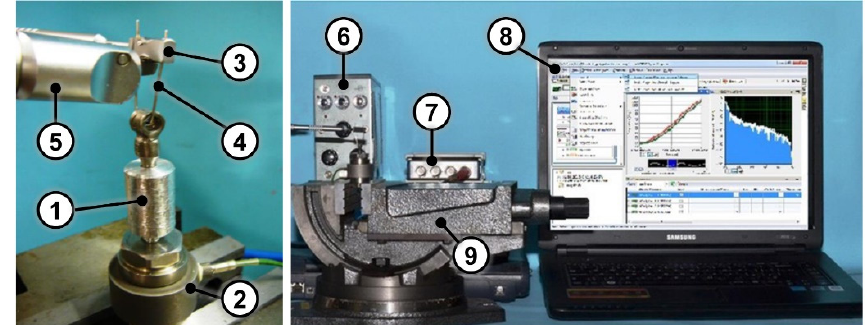
Figure 1. ( Left ) Close up view of the test setup with the cylindrical aluminum support (1), the load cell (2), the loop holder (3), the loop (4) and the Coronaflex® (5); ( Right ) Test setup composed of the amplifier (6), the data acquisition board (7), the laptop equipped with LabVIEW SignalExpress (8) and the vise